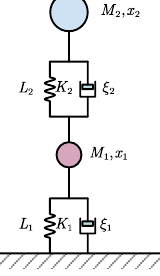
Figure 2. The robot–ground contact